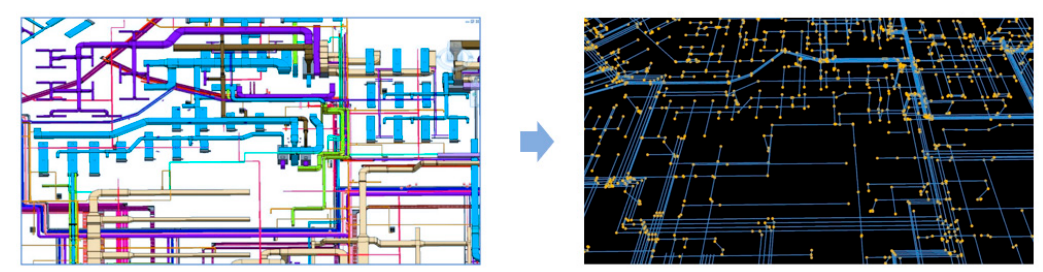
Figure 9. From BIM model to 3D pipe network data model.